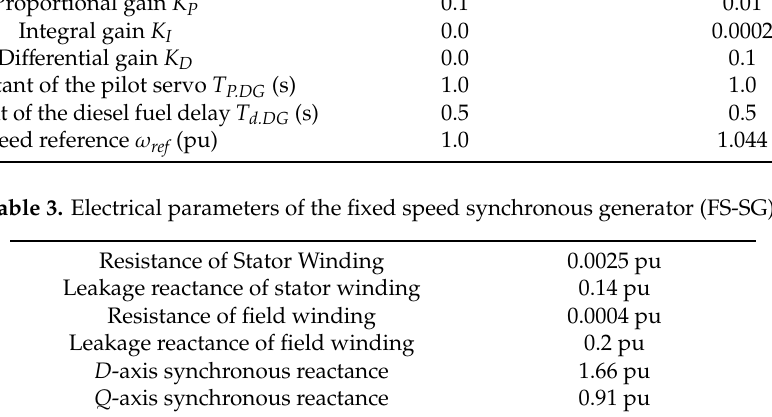
Table 3. Electrical parameters of the fixed speed synchronous generator (FS-SG).